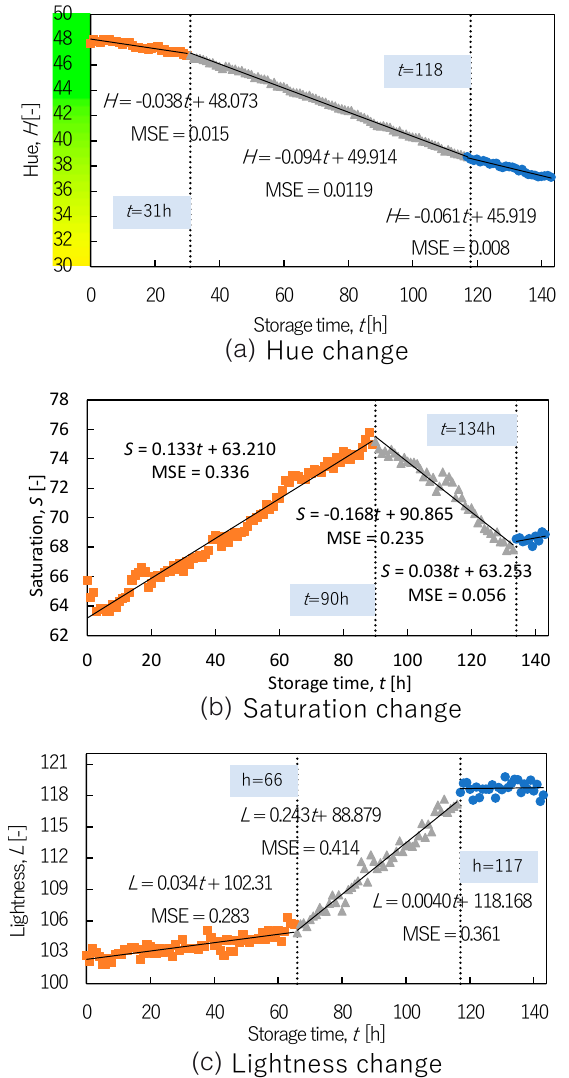
Fig. 5: The color change of the head lettuce